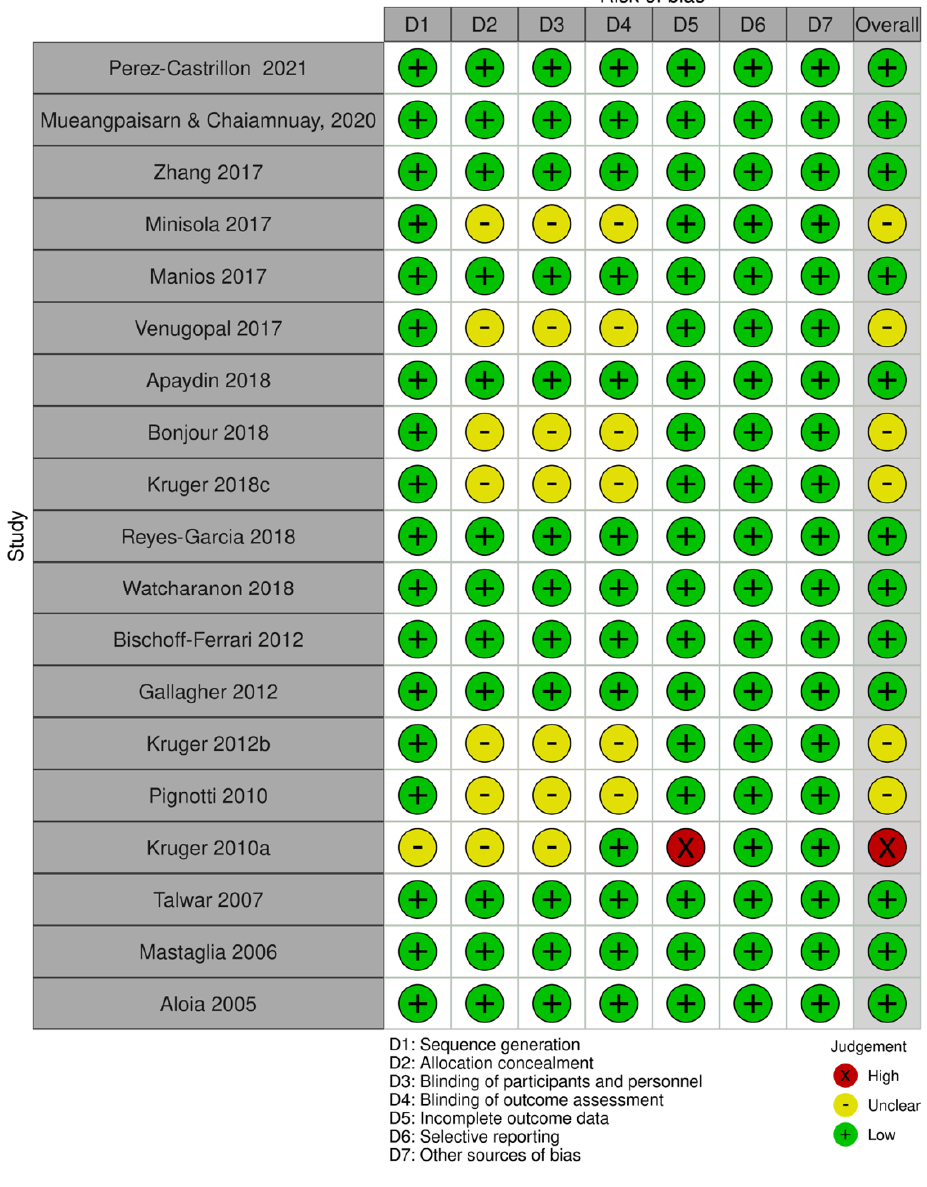
Figure 2. Risk-of-bias assessment [32–50].